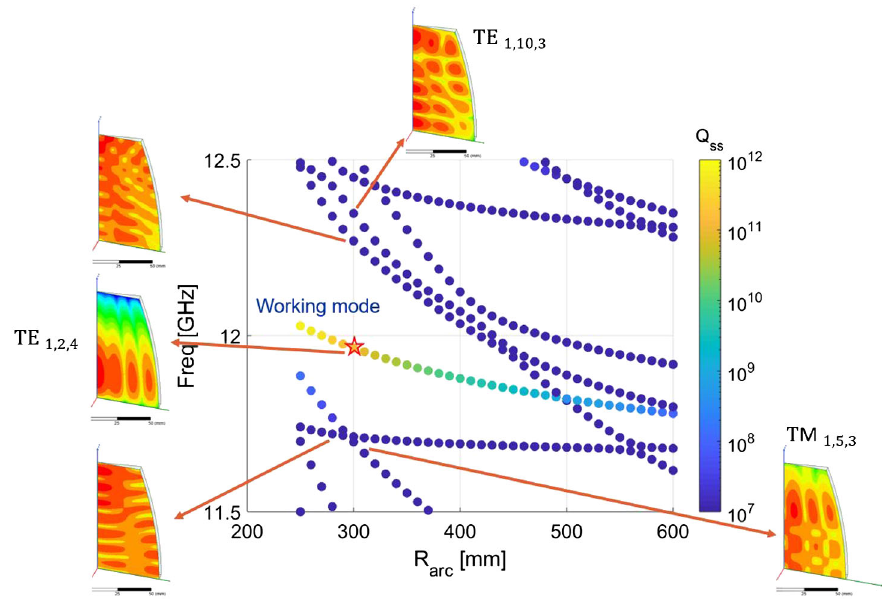
FIG. 4. Mode spectrum of TE 1 ; 2 ; 4 mode cavity. DZ fields of the working mode and the parasitic modes are presented in logarithmic